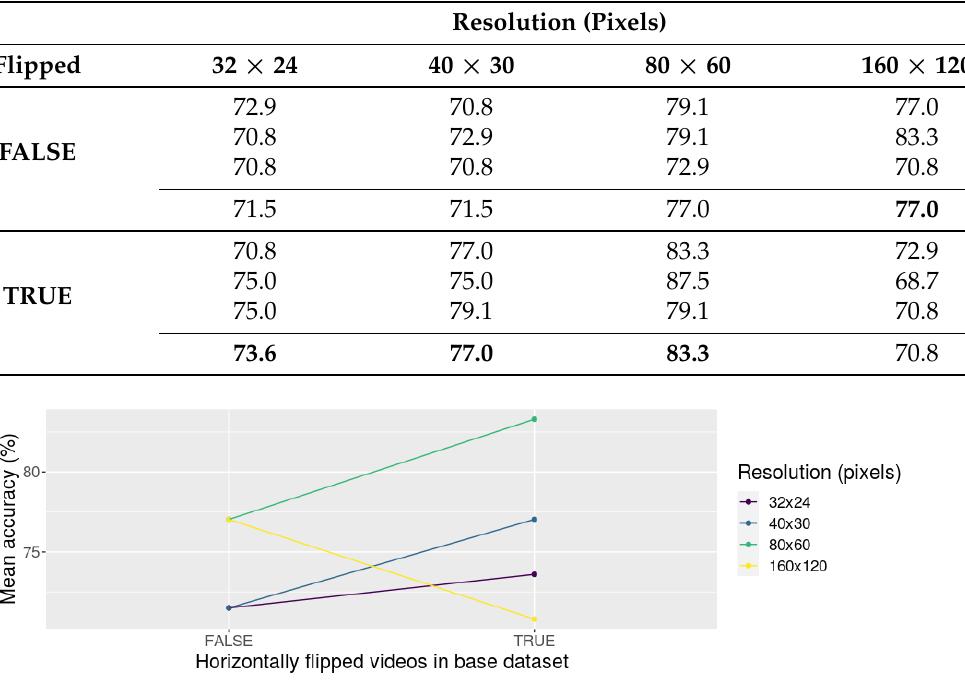
Figure 9. Interaction plot of depth (10, 30, and 90 frames) and resolution (32 × 24, 40 × 30, 80 × 60, and 160 × 120 pixels) using the accuracy values obtained from experiment P04 (using 60% of the dataset for training).